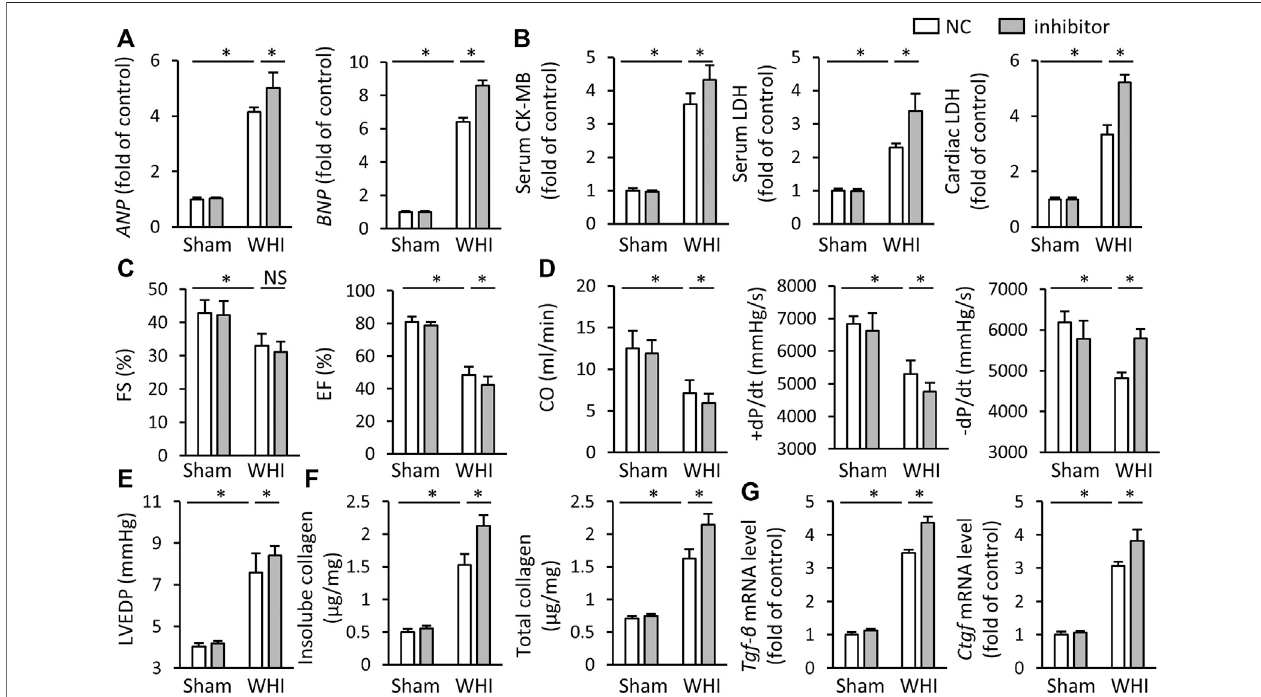
FIGURE 5 | miR-223-3p inhibitor aggravates myocardial damage and dysfunction in RIHD mice. (A) Relative mRNA levels of ANP and BNP in the hearts ( n (cid:2) 6). (B) Serum and cardiac biomarkers related to cardiac injury with or without miR-30d-5p mimic treatment upon WHI stimulation, including CK-MB and LDH ( n (cid:2) 6). (C – E) Echocardiographic and hemodynamic parameters ( n (cid:2) 6). (F) Total and insoluble collagen content were assessed in each group ( n (cid:2) 6). (G) Relative mRNA levels of Tgf- β and Ctgf in the hearts ( n (cid:2) 6). All data are presented as means ± SD. * p < 0.05 vs. the matched group.